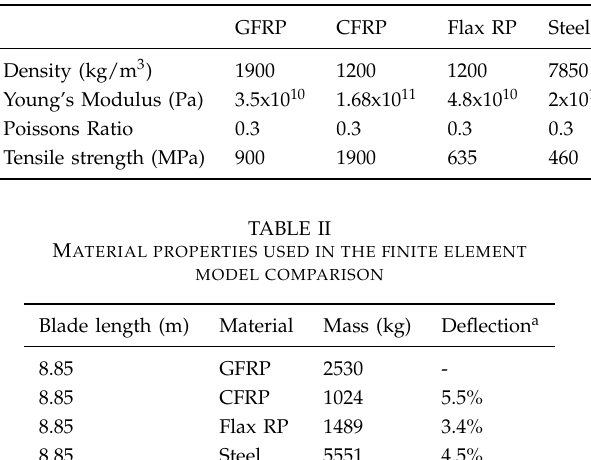
TABLE I M ATERIAL PROPERTIES USED IN THE FINITE ELEMENT MODEL